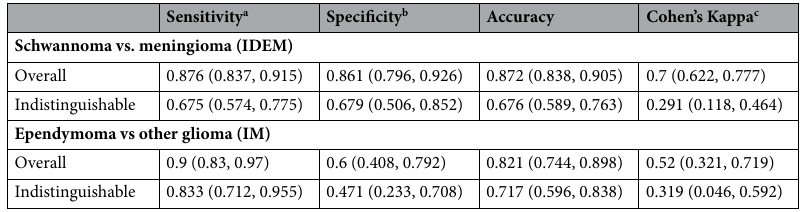
Table 4. Differentiation of schwannomas from meningiomas and ependymomas from other gliomas. Validities and their 95% confidence intervals (in parentheses). a The sensitivity of schwannoma and ependymoma (specificity of meningioma and other glioma). b The specificity of schwannoma and ependymoma (sensitivity of meningioma and other glioma). c Cohen’s Kappa coefficient between MRI report and pathologic report.